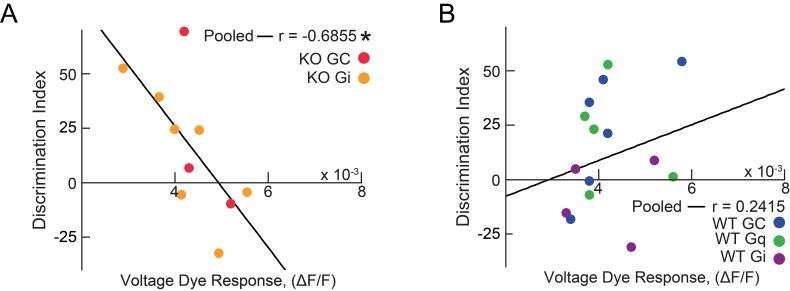
Memory Discrimination correlates to vHIP input to the mPFC in Mecp2 KO mice.(A) Correlation between social memory DI and VSD responses evoked by vHIP fiber stimulation in Mecp2 KO mice expressing mCherry (red) or hM4Di (yellow), with correlation for pooled data (n = 10 slices from 10 Mecp2 KO mice; Spearman r correlation; r = −0.6855, p=0.0287). (B) Correlation between social memory DI and VSD responses evoked by vHIP fiber stimulation in WT KO mice expressing mCherry (blue), hM3Dq (green), or hM4Di (purple), with correlation for pooled data (n = 15 slices from 15 WT KO mice; Spearman r correlation; r = 0.2415, p=0.3859).10.7554/eLife.44182.026Figure 4—figure supplement 5—source data 1.Activity of mPFC-projecting vHIP neurons modulates social memory in WT and Mecp2KO mice.